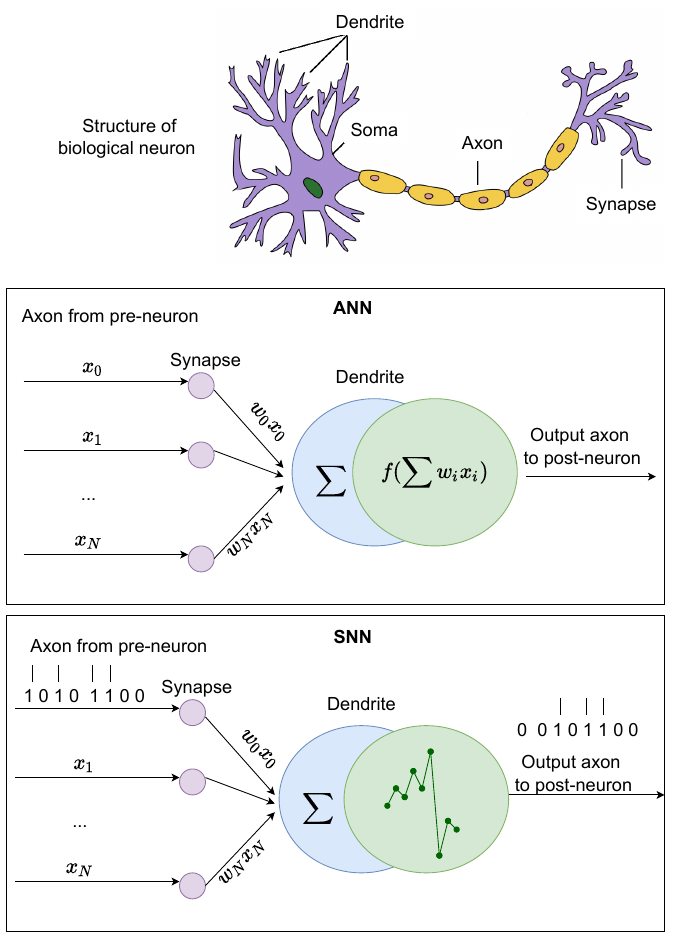
Figure 2. A comparison between the biological neuron, artificial neuron, and spiking